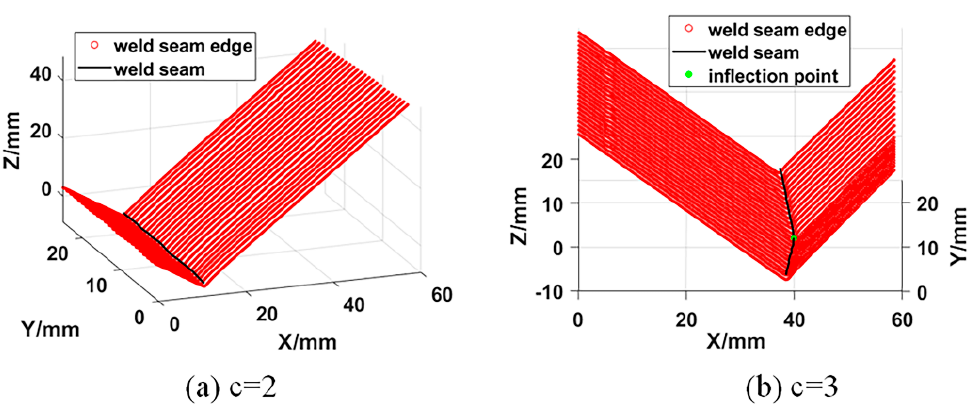
Figure 7. Welding seam trajectory fitting results; ( a ) When c = 2, the welding seam trajectory fitting result; ( b ) When c = 3, the welding seam trajectory fitting result.